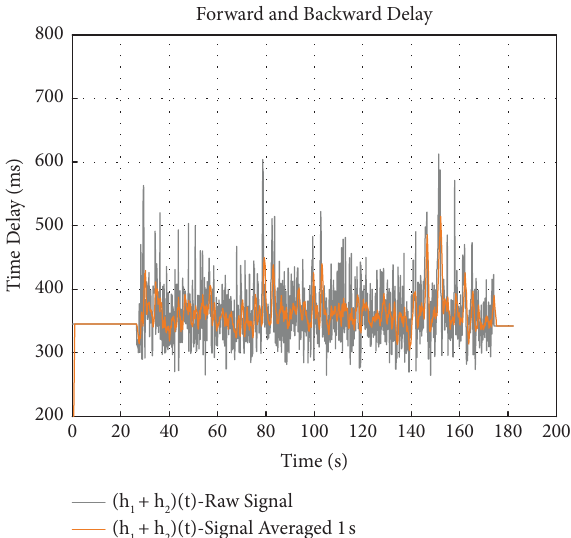
Figure 9: Total internet time delay ( h